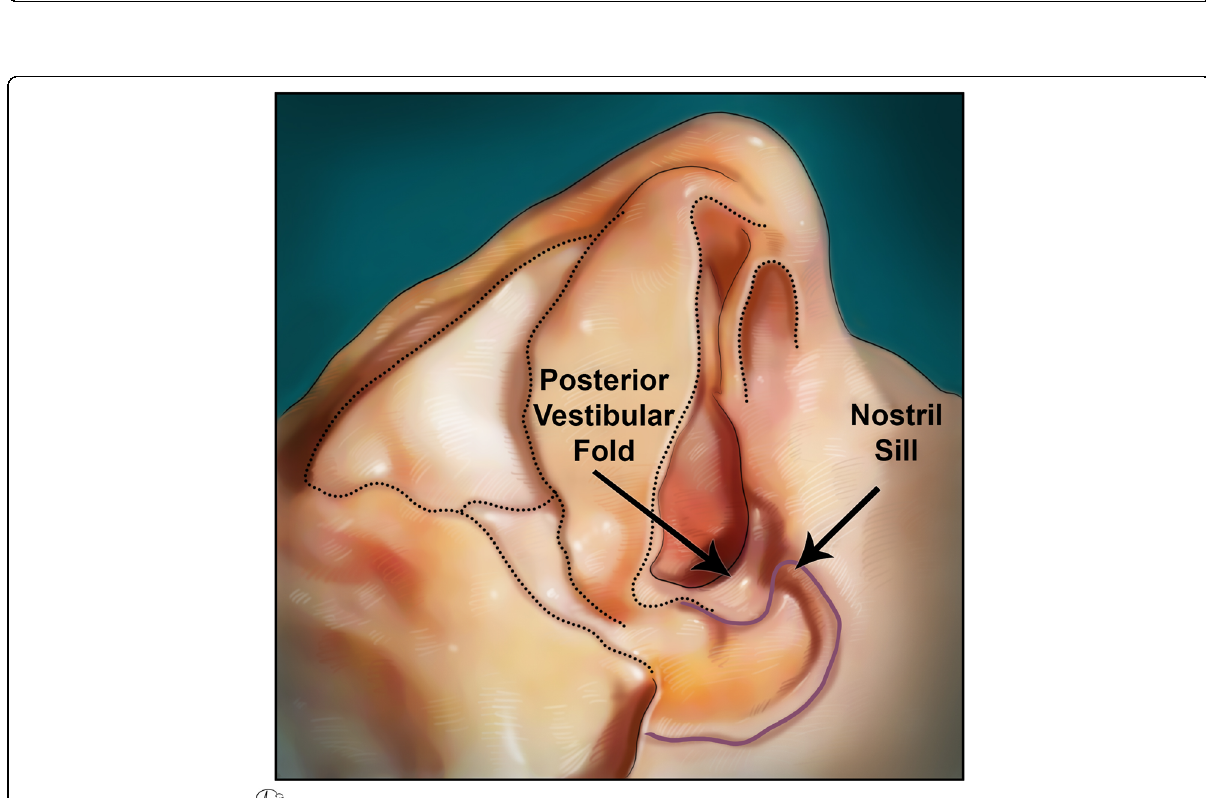
Fig. 14 The posterior vestibular fold, located adjacent to the nostril sill, is where the alveolar process separates from the nasal